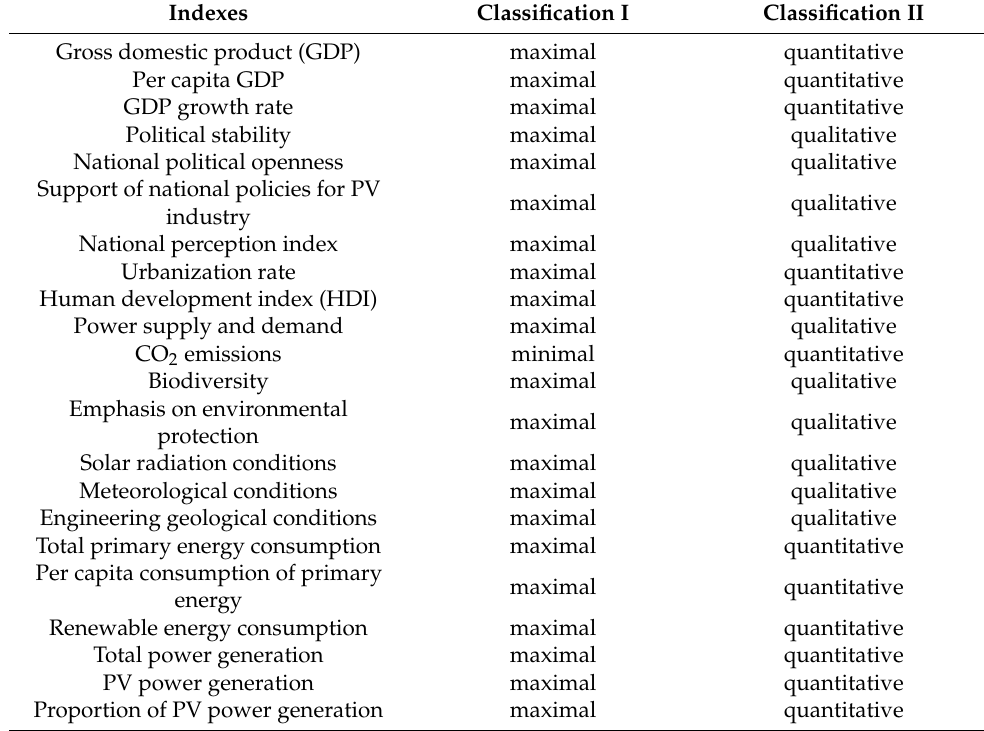
Table 2. Classification results of